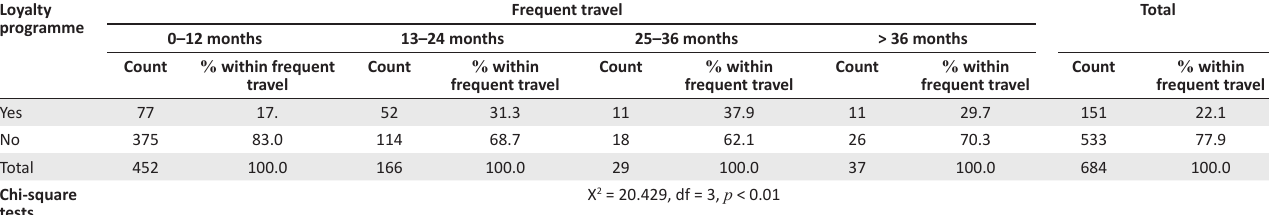
TABLE 8: Loyalty programme and frequency of travel (cross-tabulation). Loyalty